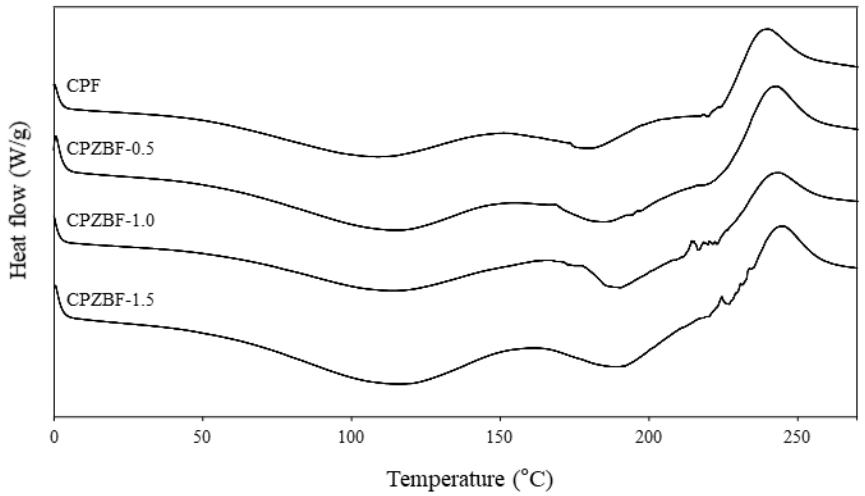
Figure 4. DSC thermograms of crosslinked pectin film (CPF) and crosslinked pectin/ZnO bionanocomposite films (CPZBF).